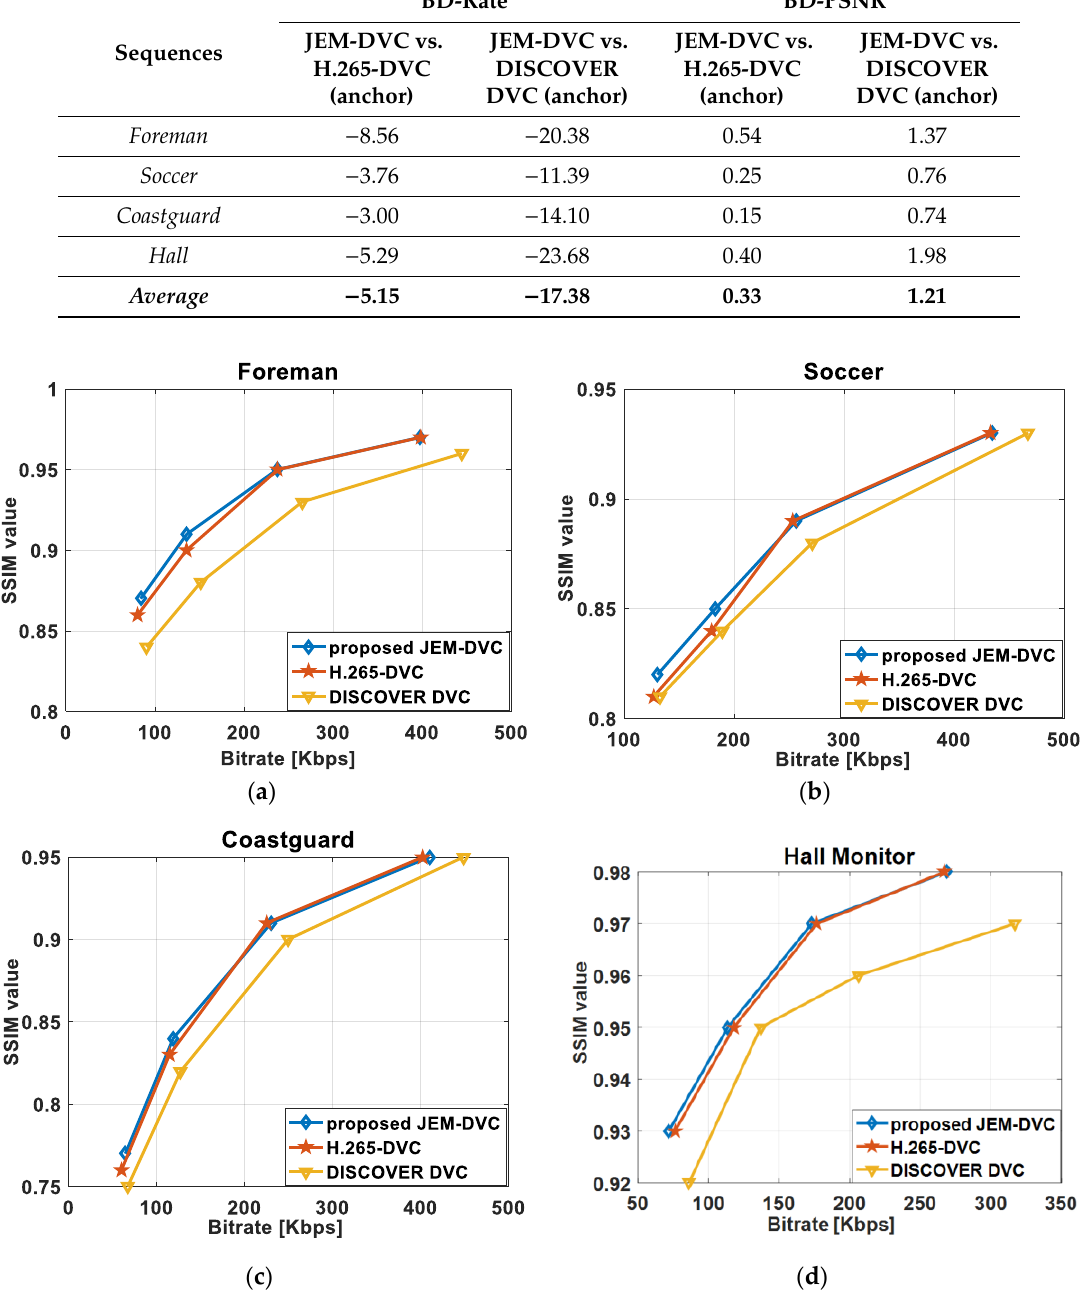
Figure 12. Comparisons of overall visual quality measurement using SSIM metric obtained by H.265-DVC, DISCOVER DVC, and the proposed JEM-DVC with different test sequences: ( a ) Foreman , ( b ) Soccer , ( c ) Coastguard , and ( d ) Hall Monitor .